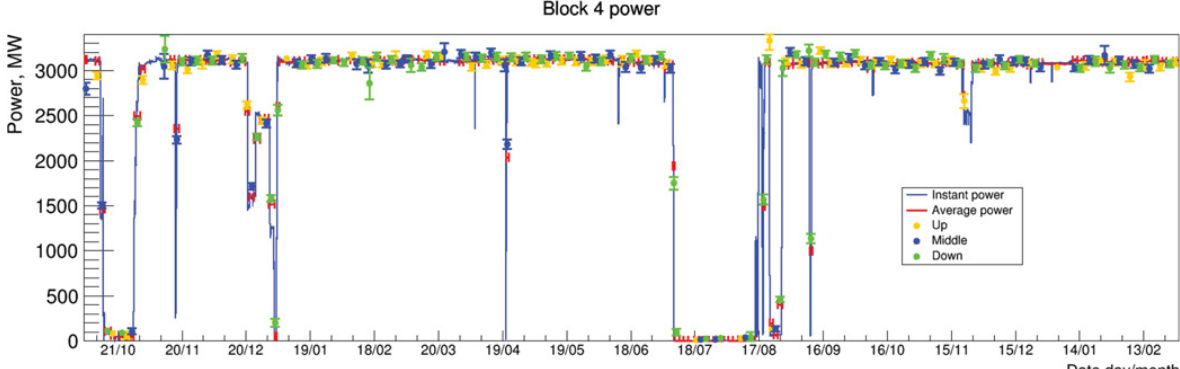
Figure 9. IBD counting rate at different detector positions (points) and the reactor thermal power. The distributions are equalized during the period November-December 2016 and therefore the IBD rate is expressed in MW. The IBD rate is corrected for the fuel evolution with time using Huber-Mueller model. Statistical errors only.